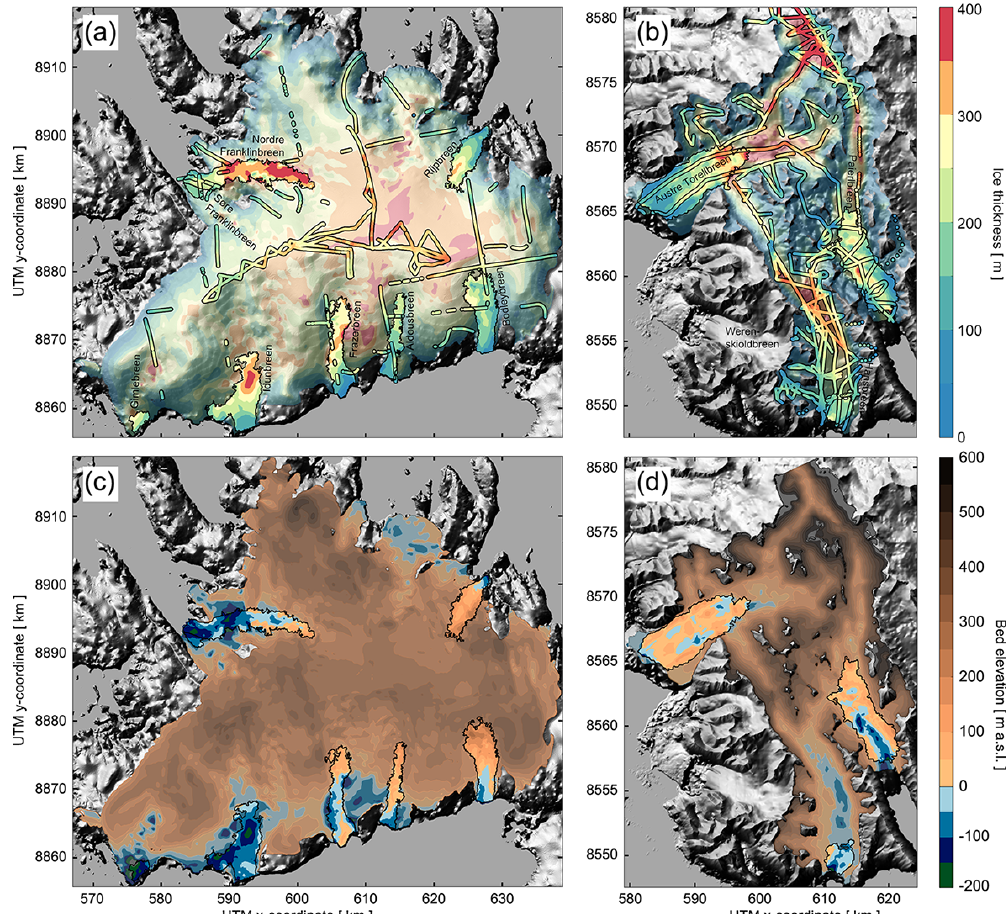
Figure 8. Ice thickness (a, b) as in Fig. 4 and associated bedrock topography (c, d) as in Fig. 5 for VIC (a, c) and THPB (b, d) . Along the outlet glaciers (non-transparent lurid colours), the two fields were updated in the second-step accounting for velocity observations in the mass conservation. Partially transparent areas in these maps (unsaturated colours) stem from the first-step reconstruction, for which values are inferred from the flux